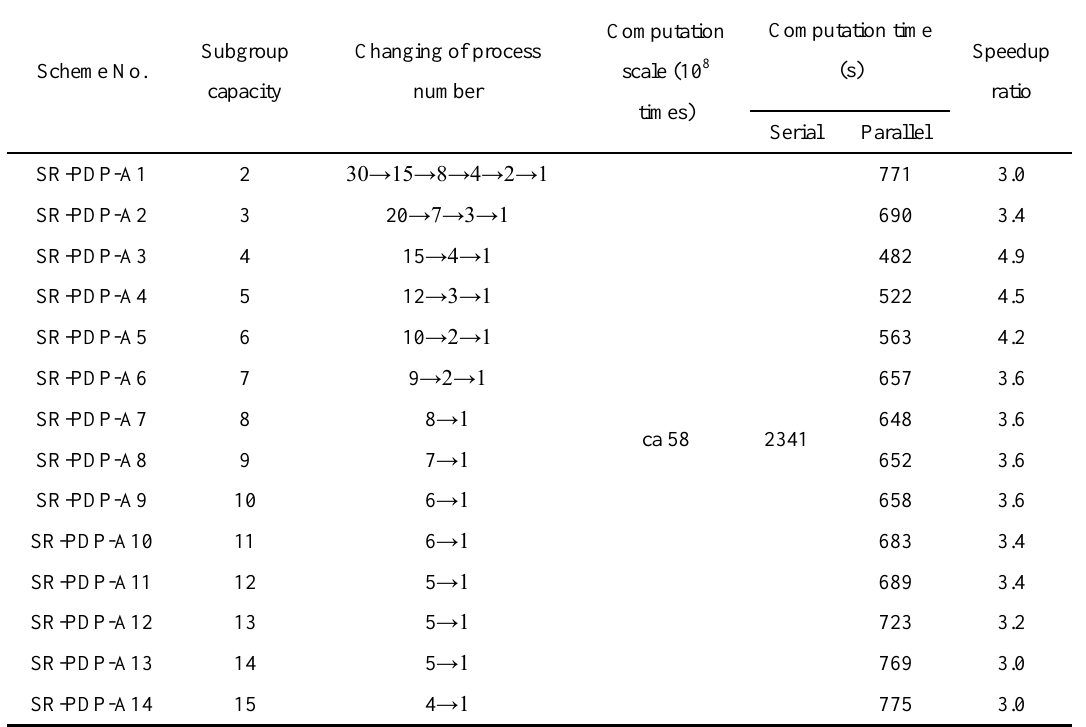
Table 1 Comparison of computation results of different subgroup capacity schemes